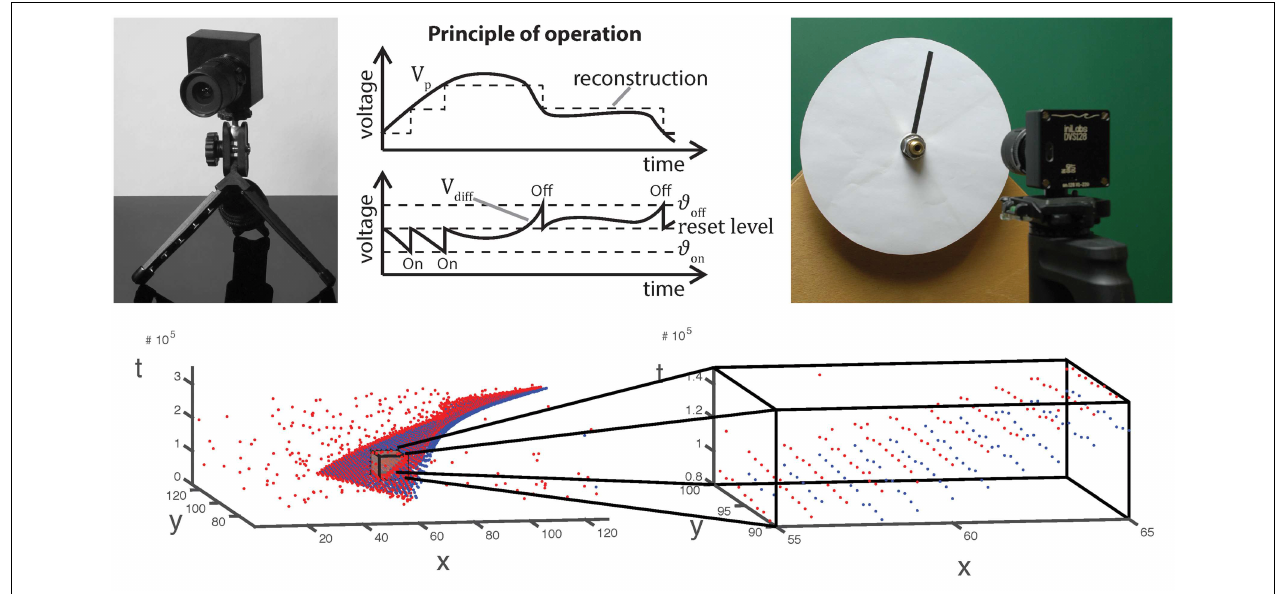
FIGURE 1 | Top from left to right: Image, operating principle and stimulus generation of/for an asynchronous event sensor. Luminance changes exceeding a given threshold evoke ON and OFF events for positive and negative changes, respectively. The very low latency of the dynamic vision